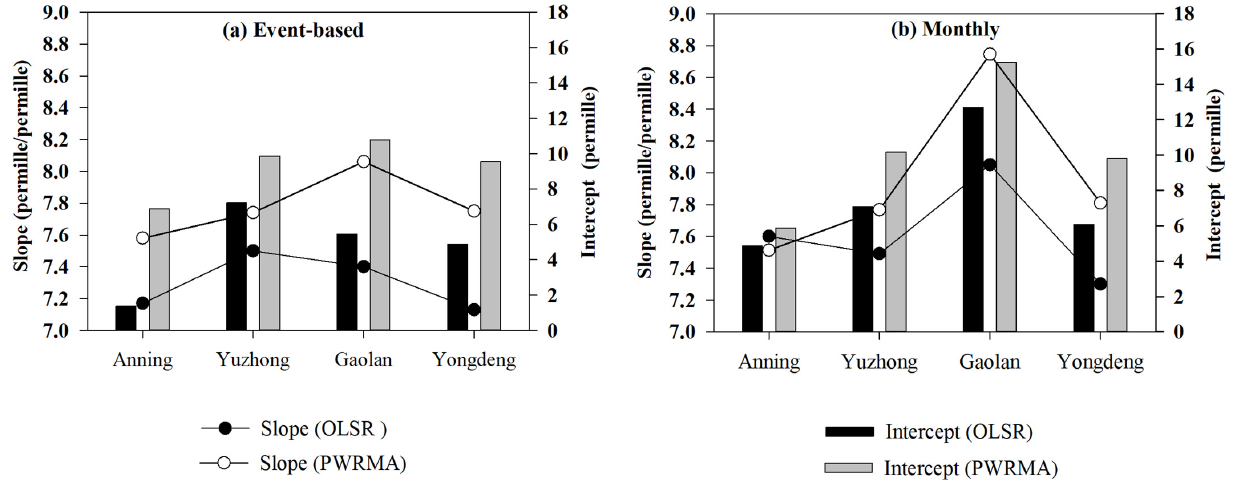
Figure 3. The slope and intercept of OLSR-based and PWRMA-based LMWL using ( a ) event-based and ( b ) monthly data for each sampling station in Lanzhou from 2011 to 2014.